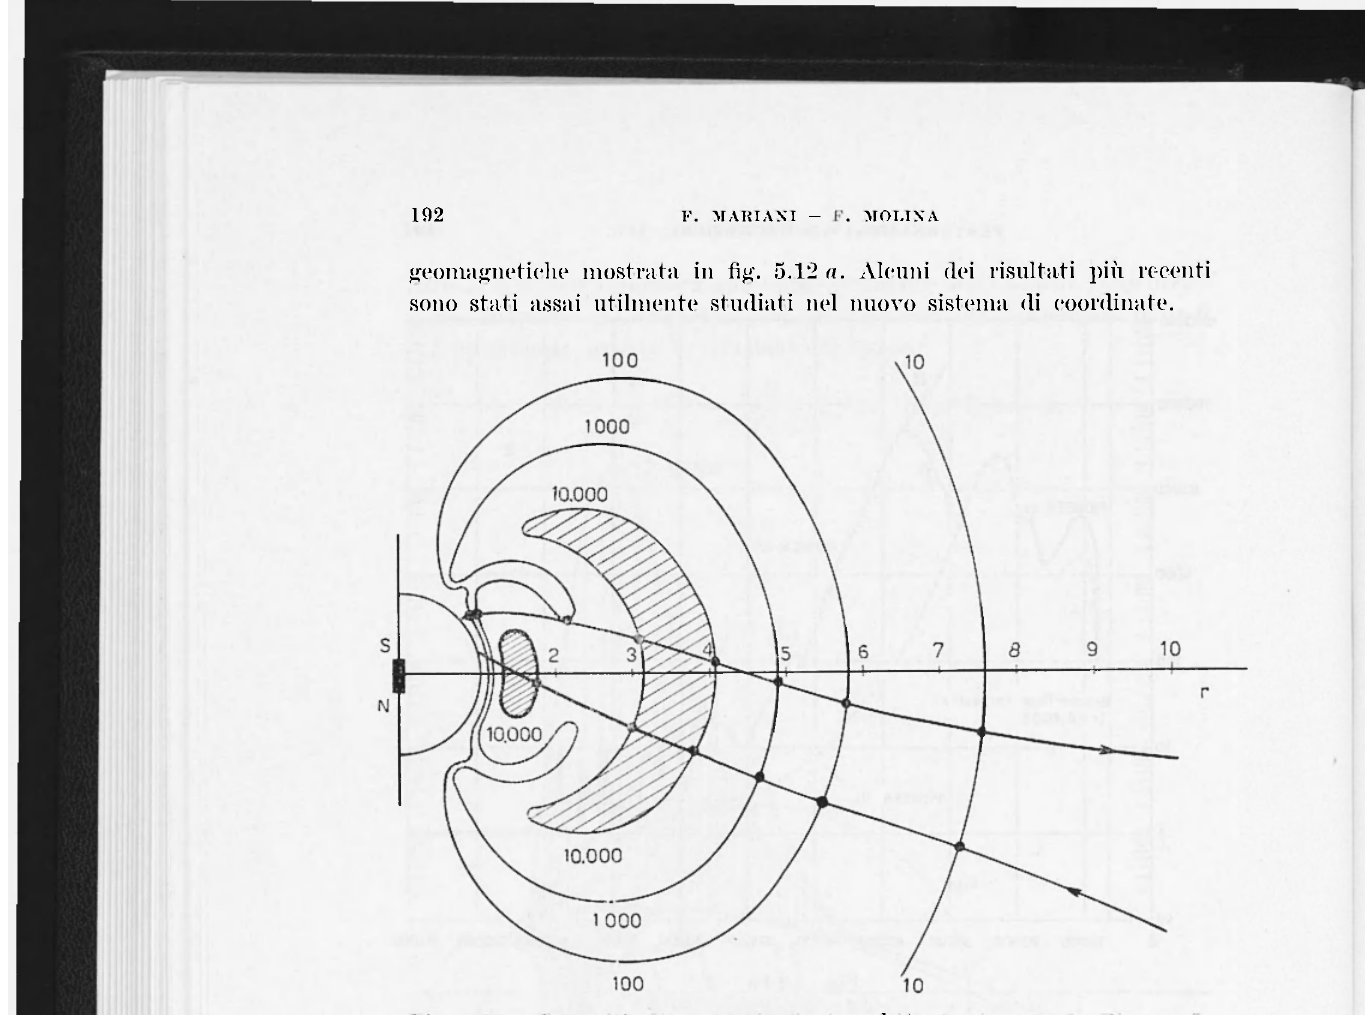
Fig. 5.15 - Intensità di conteggio (in iinpulsi/sec) misurata da Pioneer I: r, distanza geocentrica in raggi terrestri; S, N, poli sud e nord del dipolo magnetico terrestre; sono rappresentate le traiettorie (li uscita e di rientro della sonda spaziale (secondo van Alien). 5.3.3. Fiutino e spettro delle particelle intrappolate. — La più